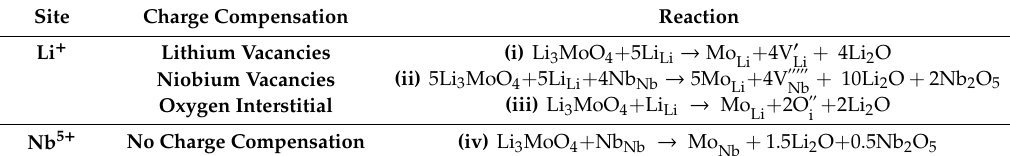
Table 9. Types of defects considered due to Mo 5+ incorporation in LiNbO 3.